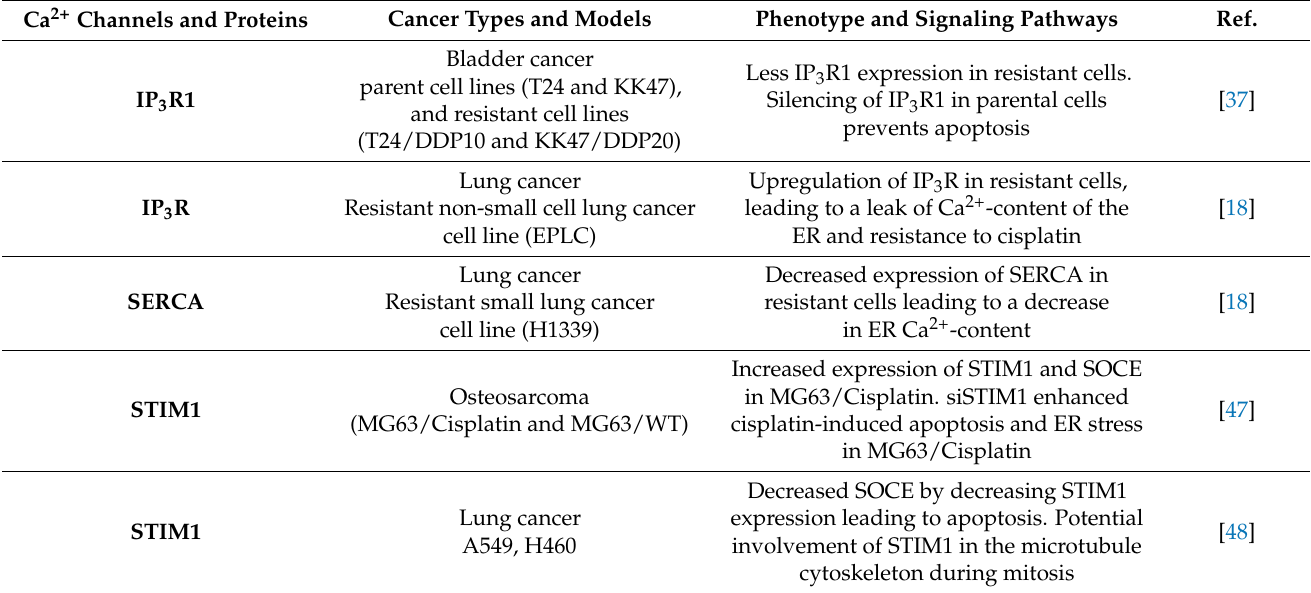
Figure 3. Summary of cisplatin-mediated resistance through Ca 2+ signaling and stemness. Chronic cisplatin exposure affects the expression of Ca 2+ channels and other Ca 2+ homeostatic proteins. On the one hand, the altered Ca 2+ fluxes activate Ca 2+ -dependent pathways that are involved in the survival of cancer cells, such as the inhibition of apoptosis and enhancement of autophagy. On the other hand, stem-related Ca 2+ -dependent transcription factors are activated, participating in the enrichment of CSC populations and their maintenance, which promotes tumor re-development. This figure was created with www.biorender.com. Table 1. Links between Ca 2+ homeostasis and cisplatin resistance in cancer.